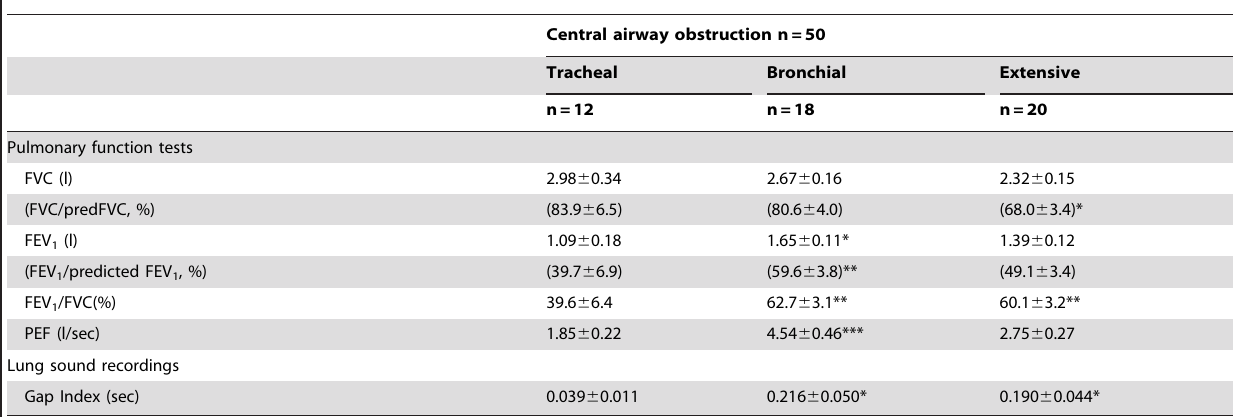
Table 2. Pulmonary function tests and lung sound recordings of patients with central airway obstruction.